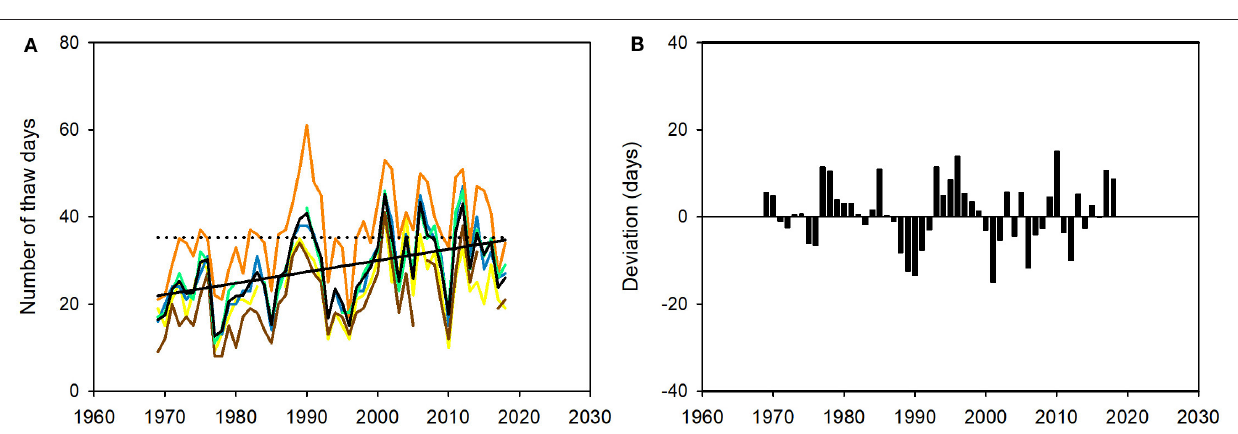
depth ranged from 2 cm · decade − 1 (Karasjok) to 6 cm · decade − 1 (Skogfoss; Figure 15B ). Number of Days With Snow Cover cover in winter (O-A) on Finnmarksvidda in 2018 ( n = 198)